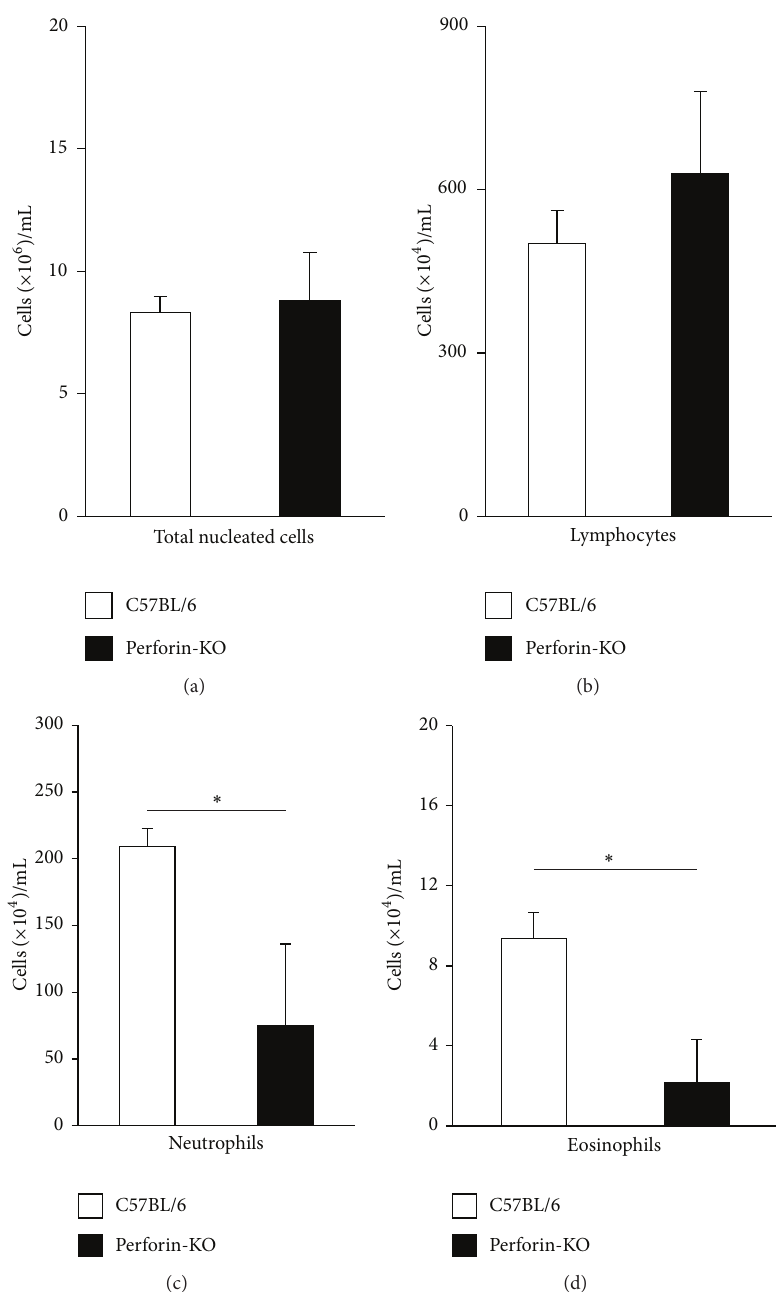
Figure 2: Total leukocyte, lymphocyte, and granulocyte counts in peripheral blood of Pfp mice and B6 wild-type controls. Data are Mean + SEM of total leukocyte (a), lymphocyte (b), neutrophil (c), and eosinophil (d) in 1mL of peripheral blood of B6 (white bars) and Pfp (black bars) matched by weight (median = 21 g, range 19g–23 g; 𝑛 = 6 for both). ∗ Significant difference between the indicated groups.